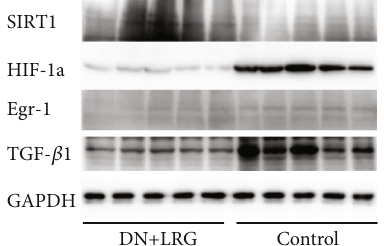
Figure 8: Western blot of SIRT1, HIF-1a, Egr-1, and TGF- β 1 protein expression in the kidney. Control: diabetic nephropathy group; DN+LRG: diabetic nephropathy+liraglutide group; Egr-1: early growth response-1; HIF-1a: hypoxia-inducible factor-1 alpha; TGF- β 1: transforming growth factor- β